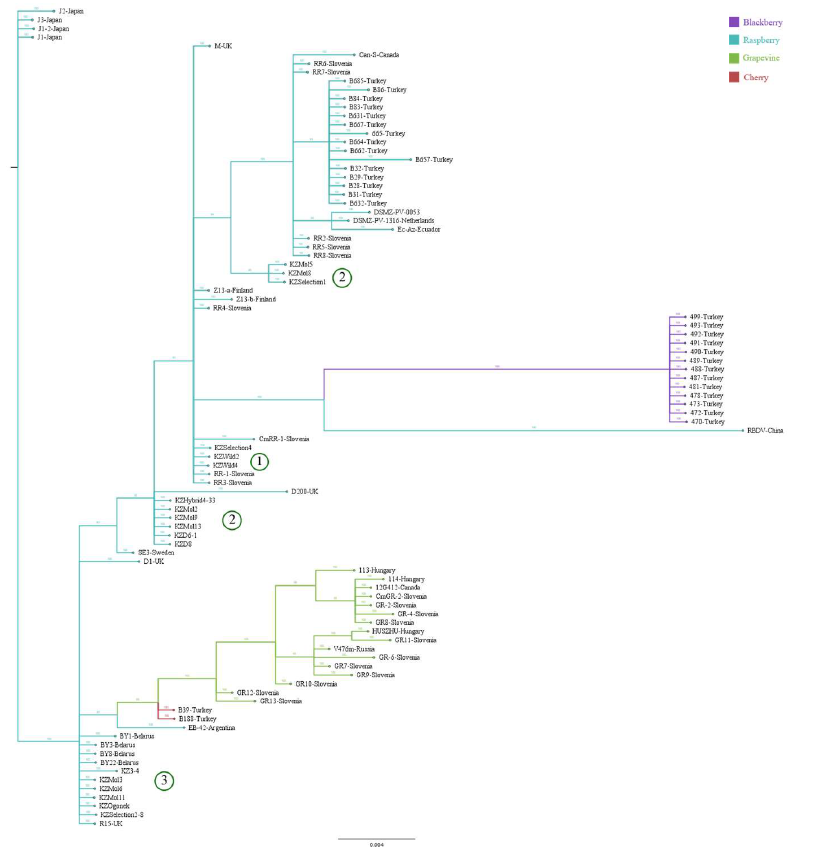
Figure 4. Phylogenetic analysis constructed from all publicly available MP sequences using Bayesian algorithm. Branches are coloured according to the plant host. Kazakhstani cluster (1), (2) and (3) are congruent with the Figure 3.